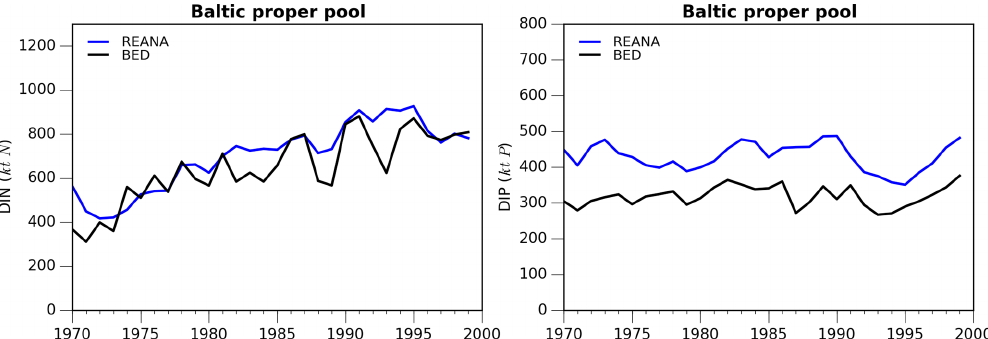
Figure 4. Annual mean integrated pools (inkt) of pelagic DIN and DIP in the Baltic proper calculated from REANA and from observations in